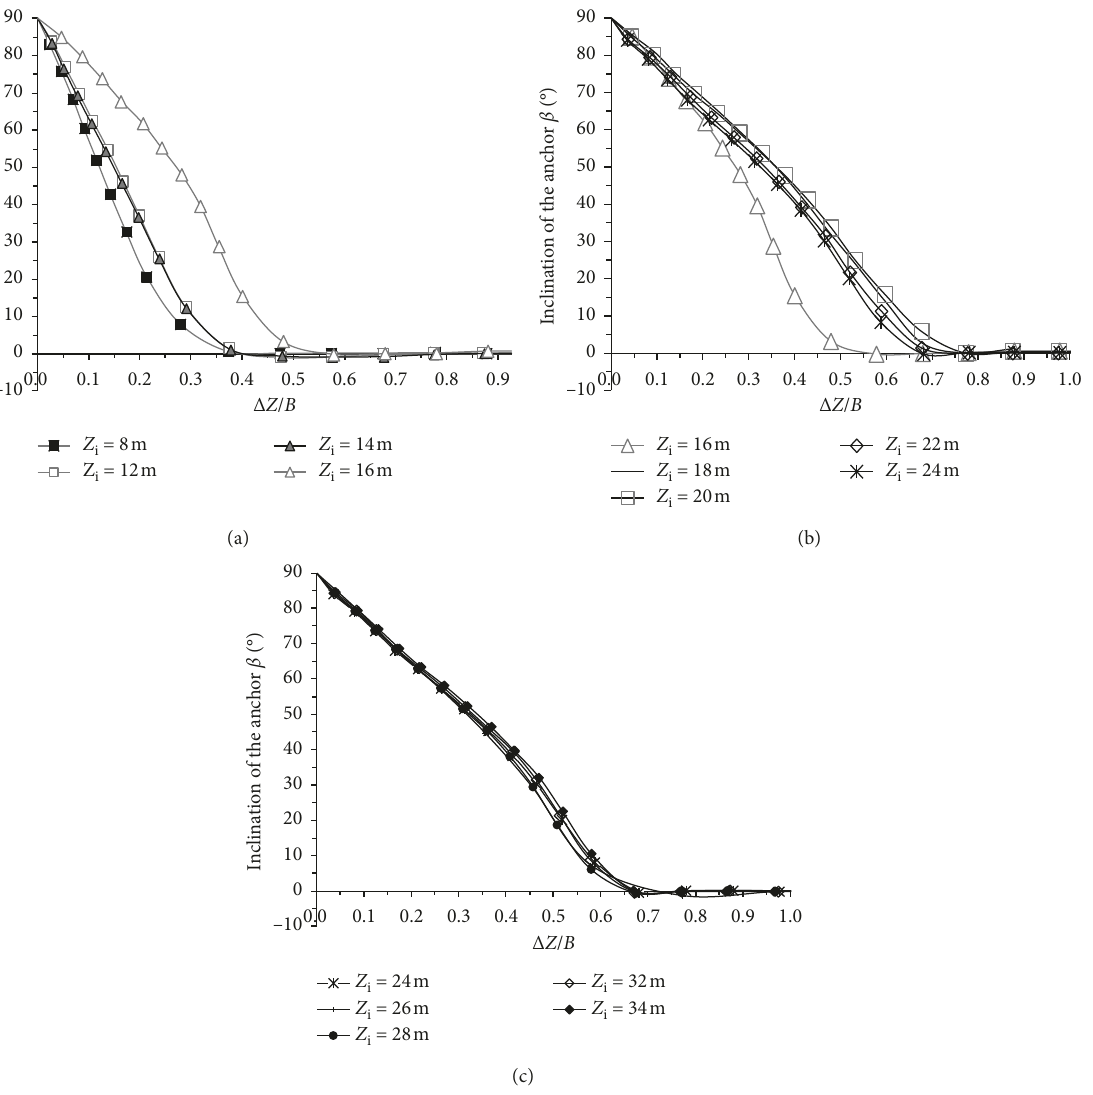
Figure 11: Variations of plate inclinations with the embedment loss in different soil layers. Plate anchor initially buried in (a) the top soil layer, (b) the middle soil layer, and (c) the bottom soil